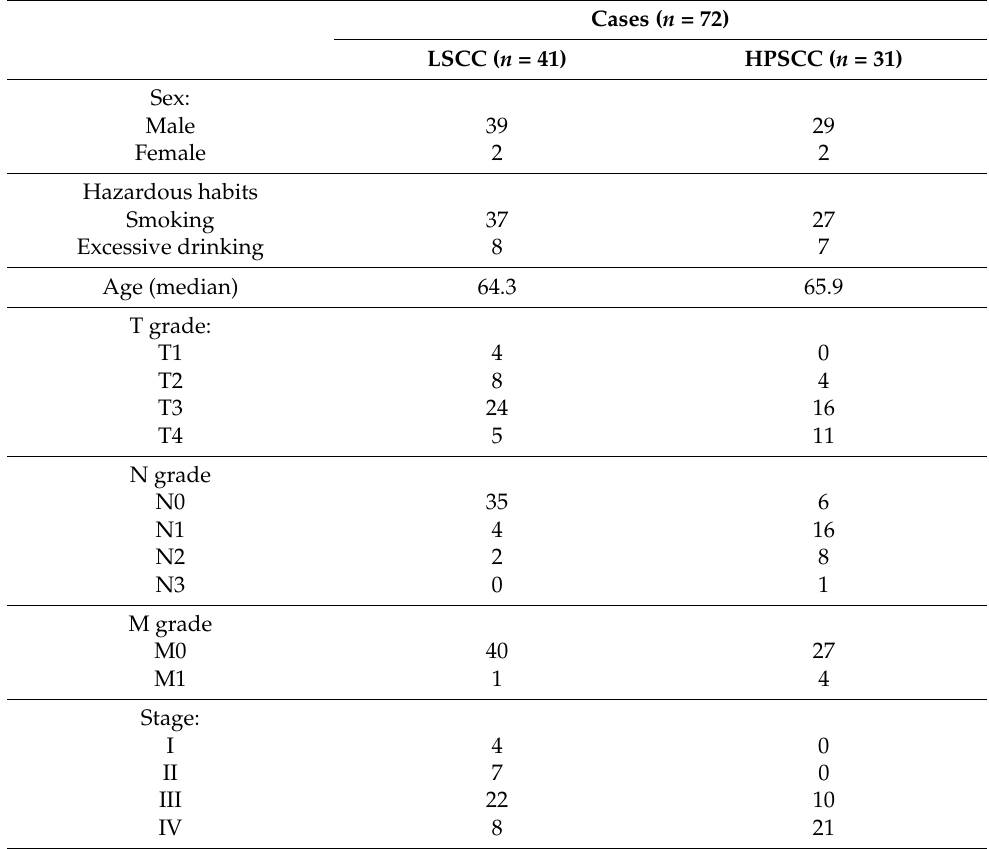
Table 1. Patients’